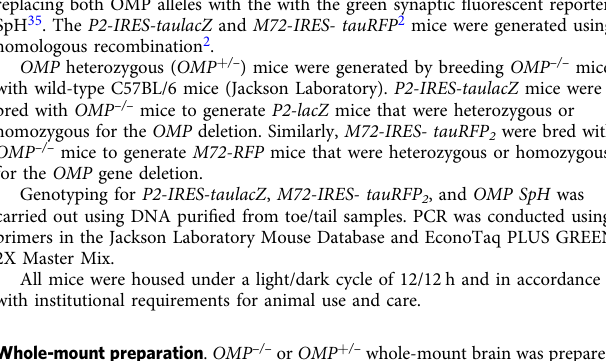
Supplementary Table 1. For OMP-GCaMP3 experiments, stimuli were delivered through a custom-built 16 channel olfactometer controlled by custom-written software in LabView. Odorants were maintained at a nominal volumetric con- centration of 16% (v/v) in mineral oil and further diluted 16 times with air for a fi nal concentration of 1%. Odors were presented for 5 s with an inter-stimulus interval of at least 40s. Odor stimulation was repeated at least three times for each fi eld of